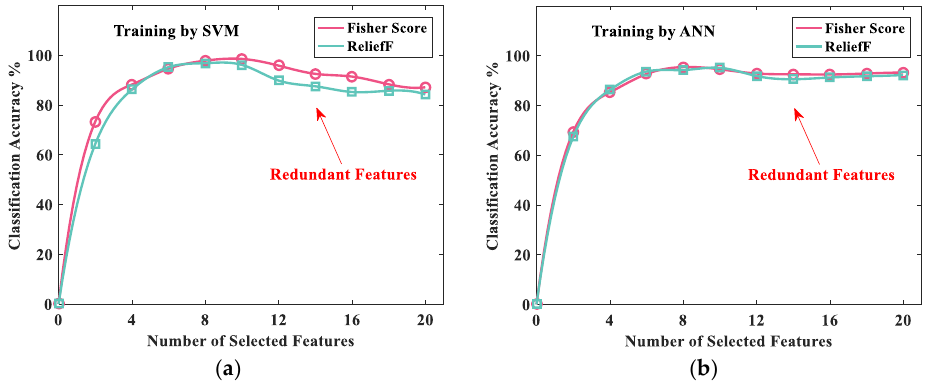
Figure 7. Identification accuracy results with different numbers of selected features. ( a ) train result by SVM model; ( b ) train result by ANN model.